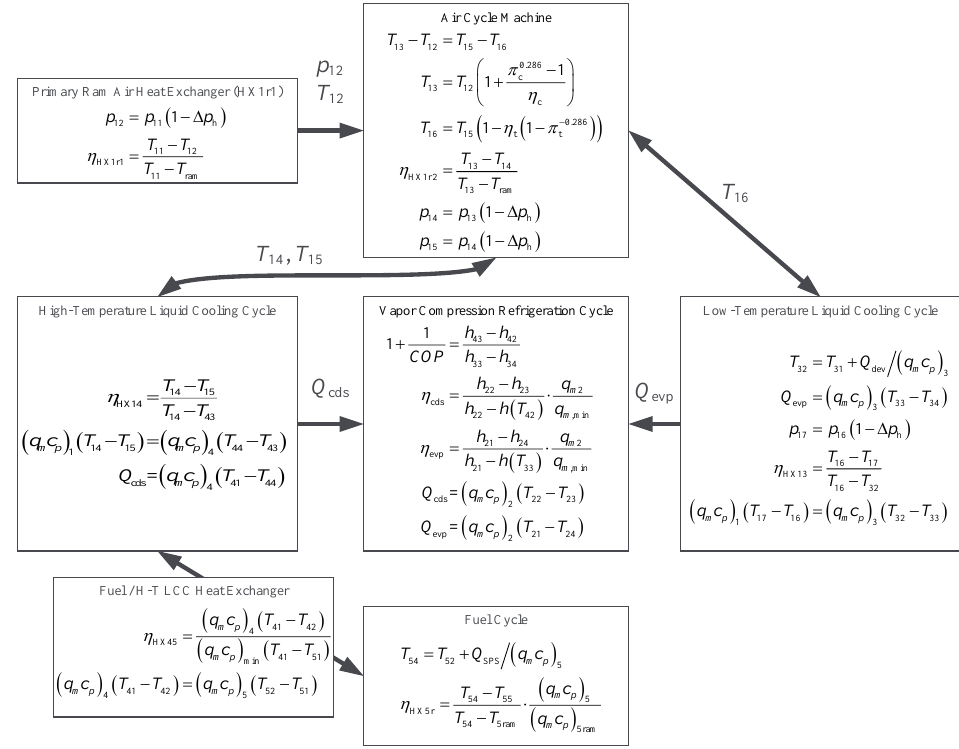
Figure 3. Structure of parameter matching algorithm of integrated thermal management